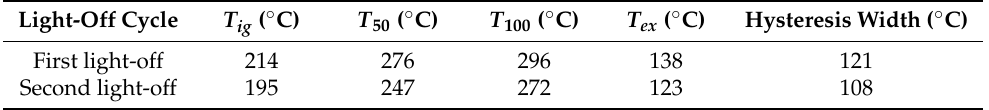
Table 1. Comparison between the catalytic ignition and extinction profile, and hysteresis width of Pd/SiO 2 aerogel catalysts of the first and the second light-off (ignition) cycles. Light-Off Cycle First light-off 214 276 296 121 Second light-off 195 247 272 123